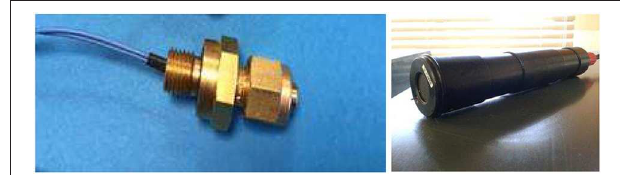
FIGURE 1 | Photo of SST sensor (left) and of MoSens device with HRSST sensor (right) .